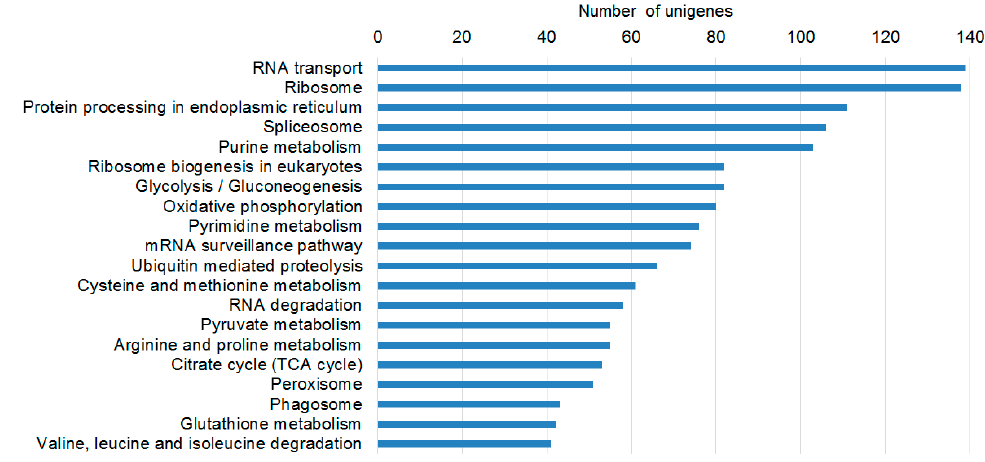
Figure 4. Top 20 KEGG pathways in P. aegyptiaca germinating seeds according to the numbers of DEGs . This Figure shows the KEGG metabolic pathways of plants that were well represented by unique sequences of P. aegyptiaca .